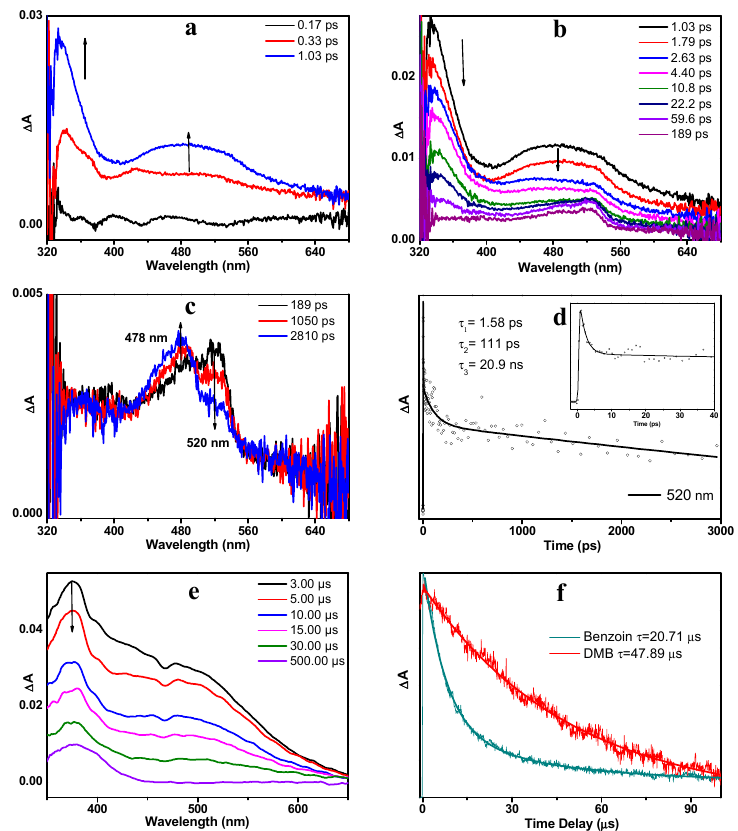
Figure 7. The fs-TA spectra of benzoin in MeCN obtained upon 266 nm excitation ( a ) from 0.17 ps to 1.03 ps, ( b ) from 1.03 ps to 189 ps, ( c ) from 189 ps to 2.81 ns. ( d ) Kinetics trace monitored at 520 nm in MeCN. The solid line depicts the best fitting. (Inset) The enlargement of kinetic trace from 0 to 40 ps. ( e ) ns-TA spectra of benzoin in MeCN obtained upon 266 nm excitation. ( f ) Normalized transient absorption dynamics of benzoin and DMB in MeCN monitored at 400 nm.